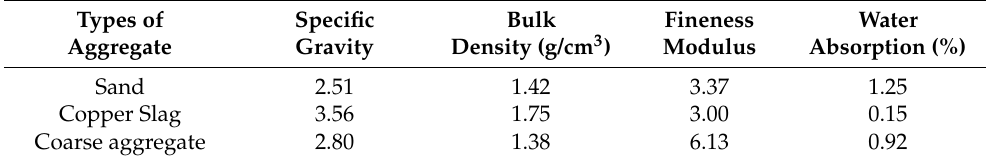
Figure 1. ( a ) Copper slag and ( b ) PPFs. Table 1. Properties of sand, copper slag, and coarse aggregate.